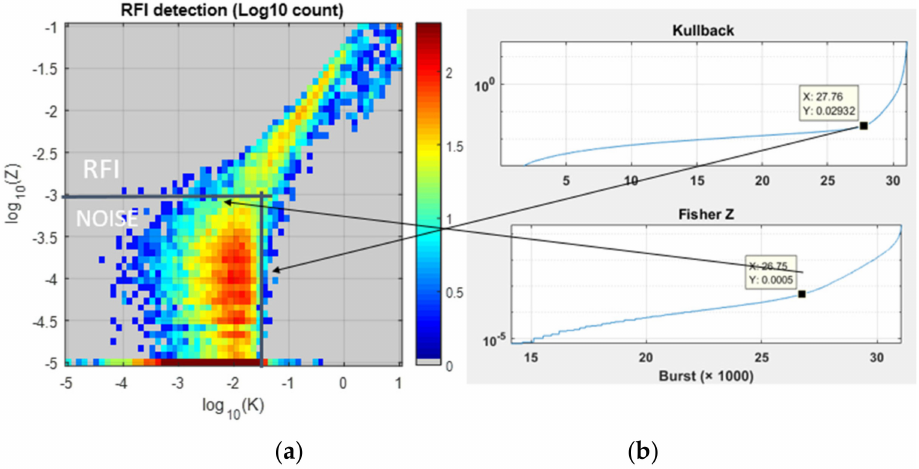
Figure 8. ( a ) Bidimensional histogram, counting the power spectra as function of Kullback-Leibler divergence (K), horizontal, and Fisher figure of merit, (Z), vertical, both in log scale. The two classes, marked as noise and RFI, can be separated better in the 2D than by a single figure of merit, either Z, or K; ( b ) Marginal histograms representing the RFI pdf with respect to Fisher and KL divergence.